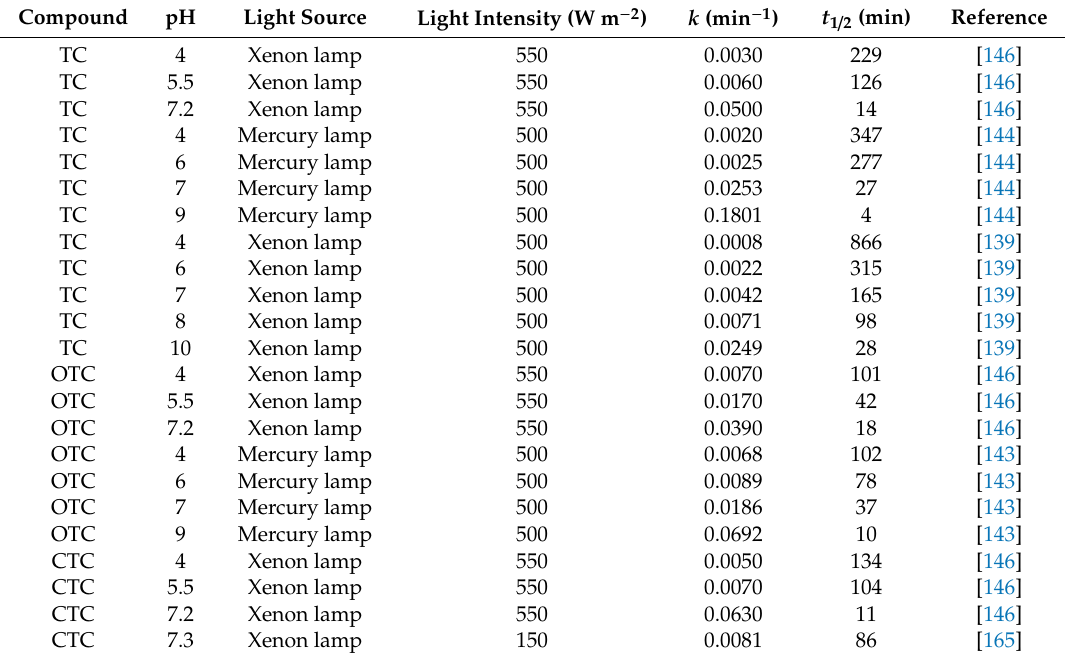
Table9. Velocityconstant( k )andhalf-life( t 1 / 2 )valuesobtainedbydi ff erentauthorsforphotodegradation of tetracycline antibiotics in aqueous media.